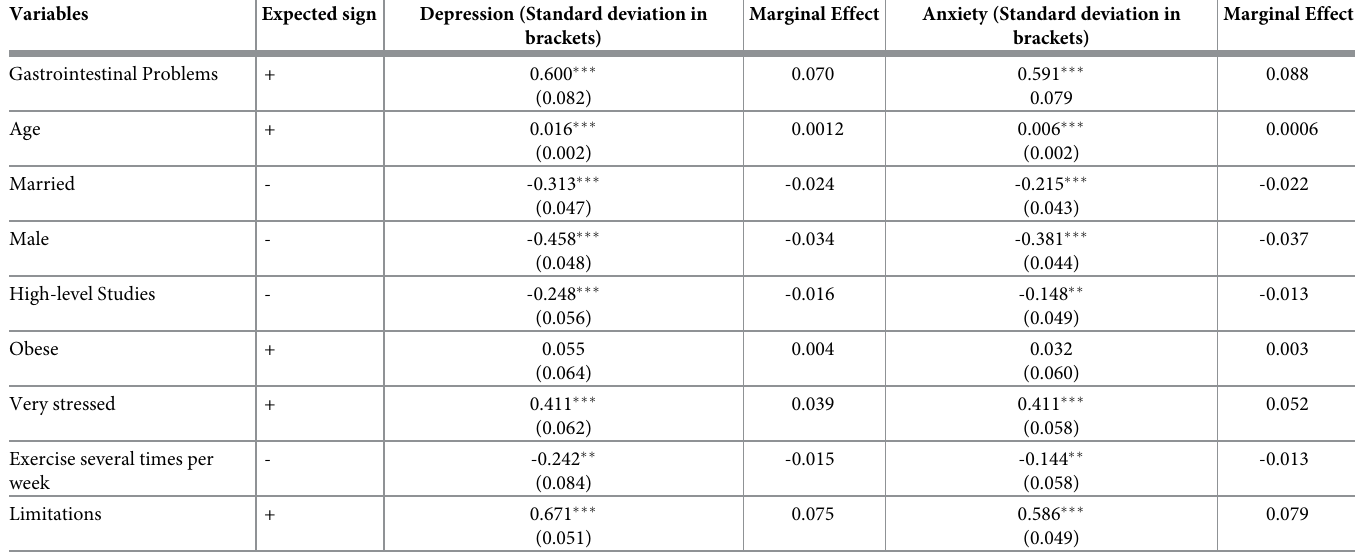
Table 2. Probability of having depression or anxiety and marginal